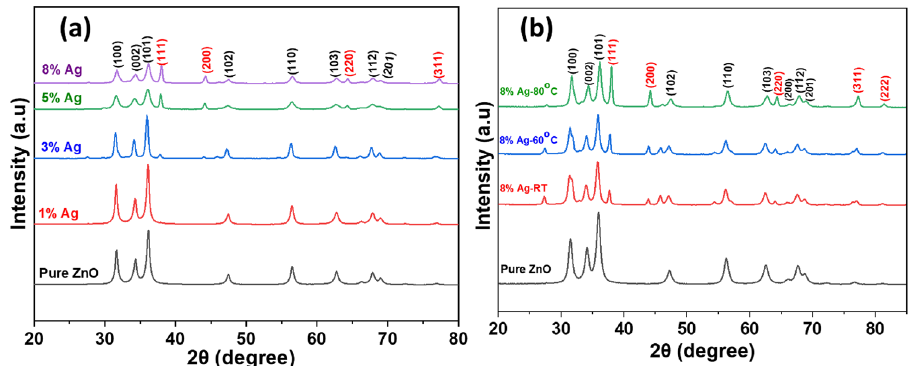
Figure 2. XRD patterns ( a ) pure ZnO and Ag–ZnO nanocomposites at different Ag content (1% Ag, 3% Ag, 5% Ag, 8% Ag) and ( b ) pure ZnO and Ag–ZnO nanocomposites at different synthetic temperatures (RT (30 °C), 60 °C and 80 °C) (The characteristic peaks for Ag are in red